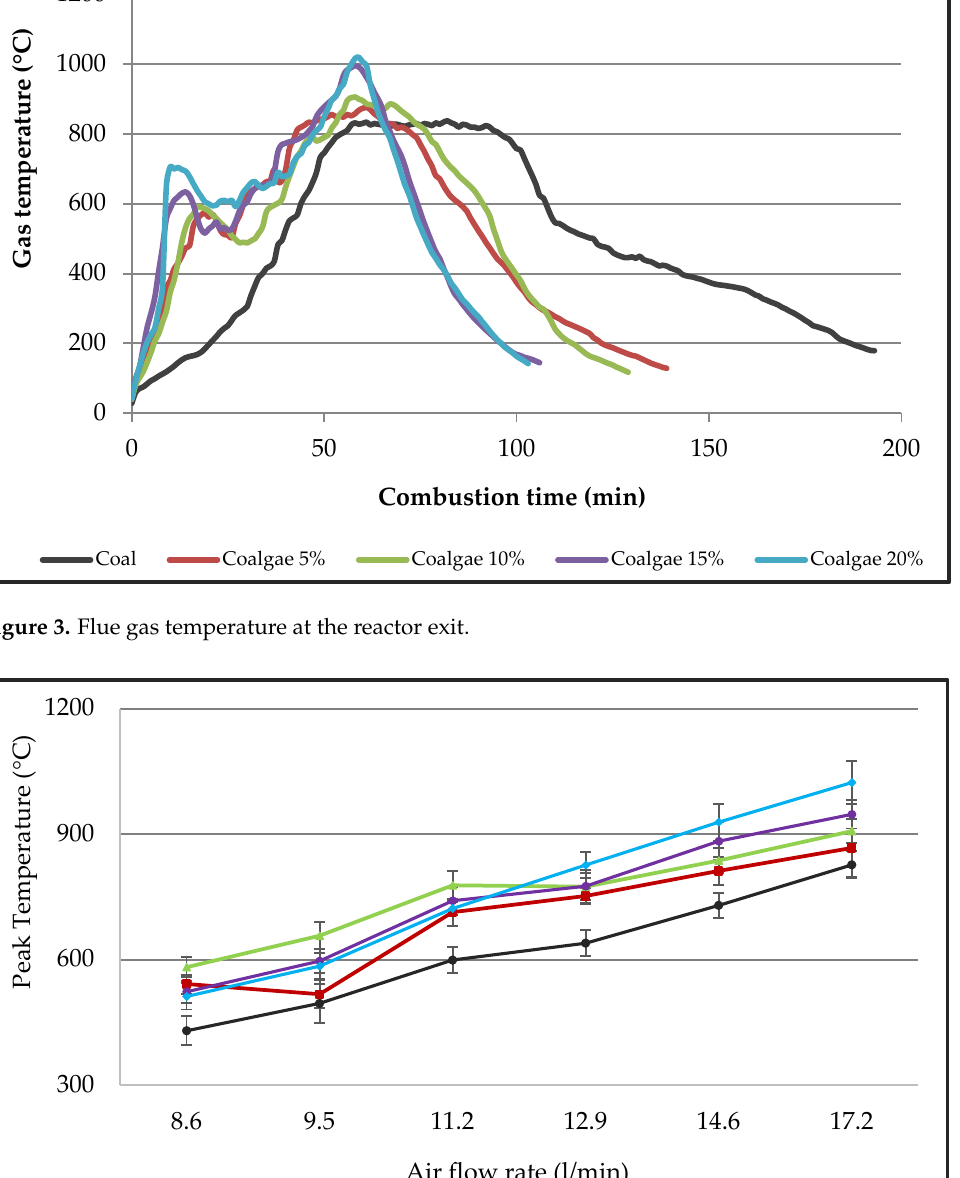
Figure 3. Flue gas temperature at the reactor exit.